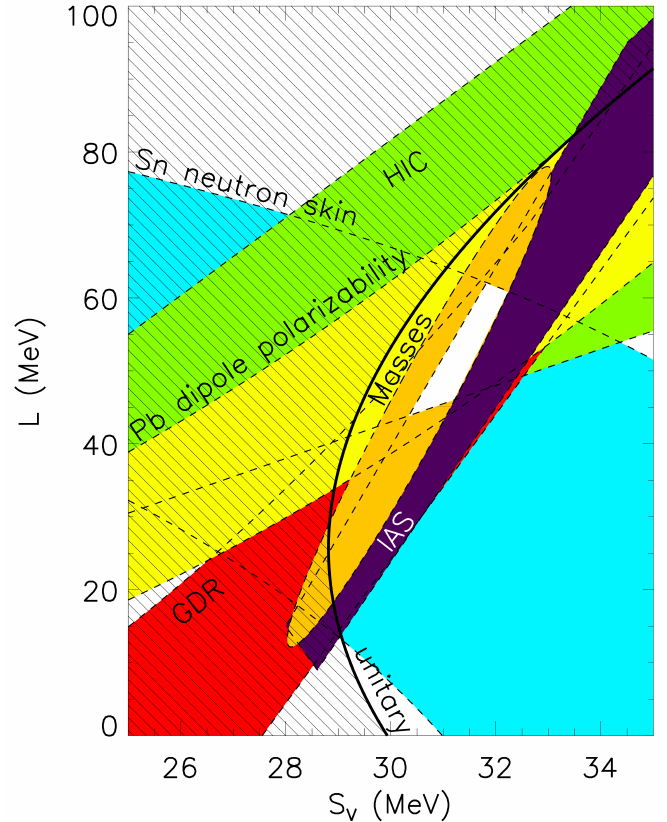
Figure 3. Experimental constraints on the nuclear symmetry properties compared with those of the unitary gas conjecture . HIC, IAS and GDR are from heavy-ion collisions, isobaric analog states and centroid energies of giant dipole resonances, respectively (see Lattimer and Lim [1] for